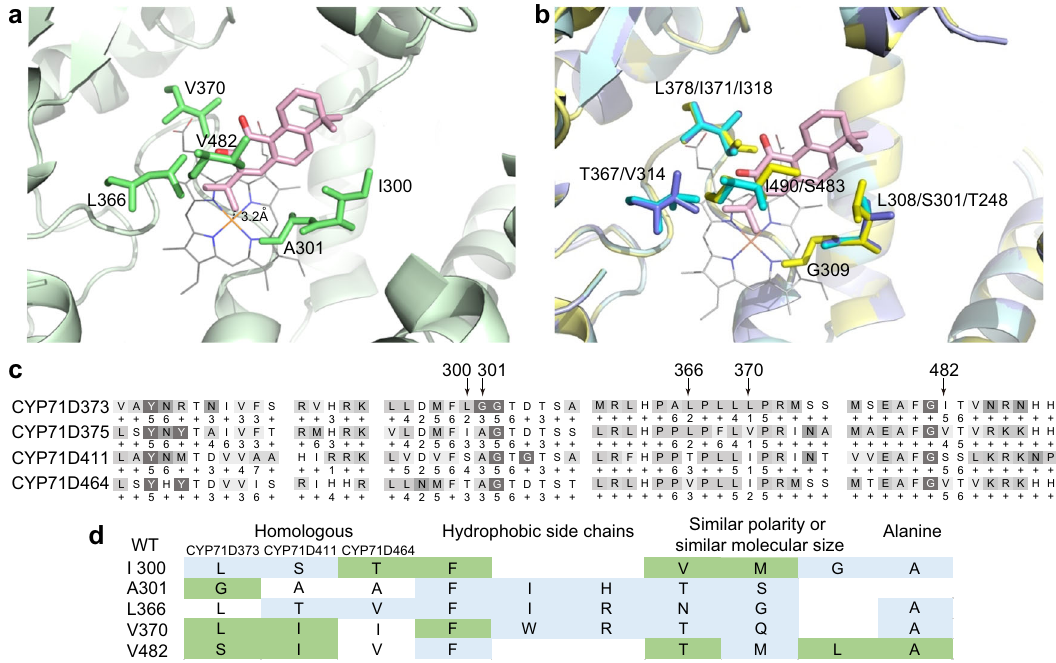
Fig. 7 Docking analysis and mutation veri fi cation of CYP71Ds active sites in catalyzing miltirone. a Docking result for miltirone (pink) in the CYP71D375 model, with side-chains for the targeted residues shown (green). b Docking result for miltirone, with side-chains of the targeted residues shown (as indicated), in the models for CYP71D373 (yellow), CYP71D411(blue) and CYP71D464 (purple). c Alignment of the regions around the fi ve proposed distinguishing active site residues. d Table indicating positive (green) and negative (blue) impact of CYP71D375 mutations on enzymatic reaction with